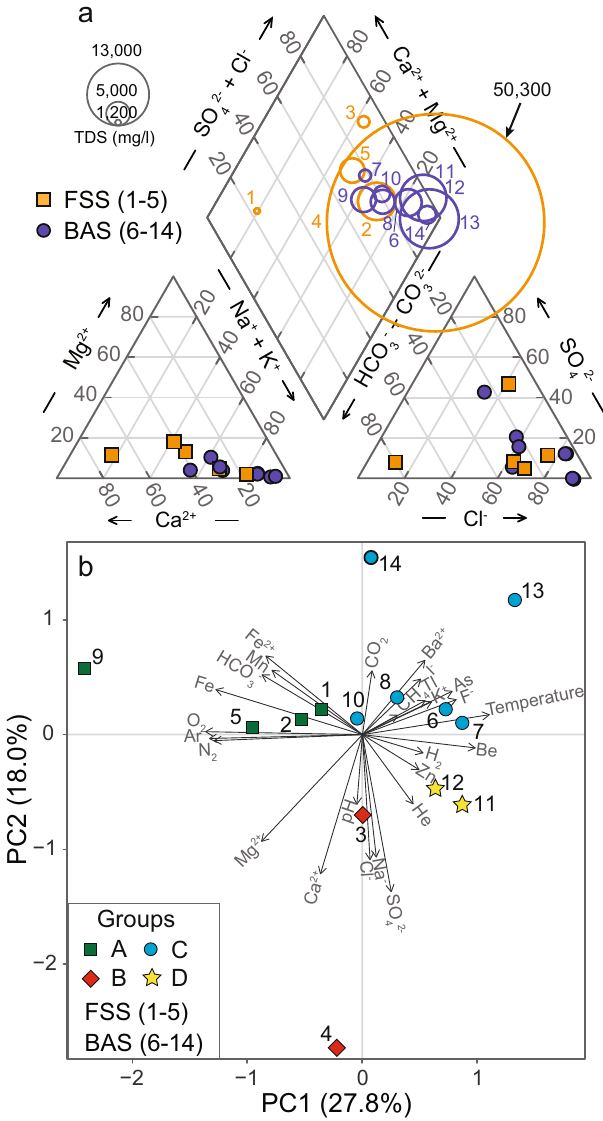
Fig. 2 Geochemistry of 14 hot springs in the fl at-slab and back-arc regions of Peru. a Piper diagram showing the major ion chemistry and TDS for fl at-slab springs (FSS) and back-arc springs (BAS; note Sp. 4 TDS). b Principal component analysis (PCA) based on the measured aqueous, gas, and isotope geochemistry. Springs separate into four groups FSS into A&B; BAS into C&D, with one major exception (Sp. 9). This lower temperature BAS falls into PCA group